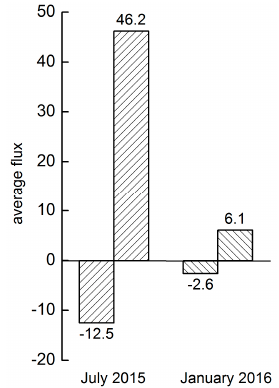
Figure 6. Average value of fluxes in July 2015 and January 2016.